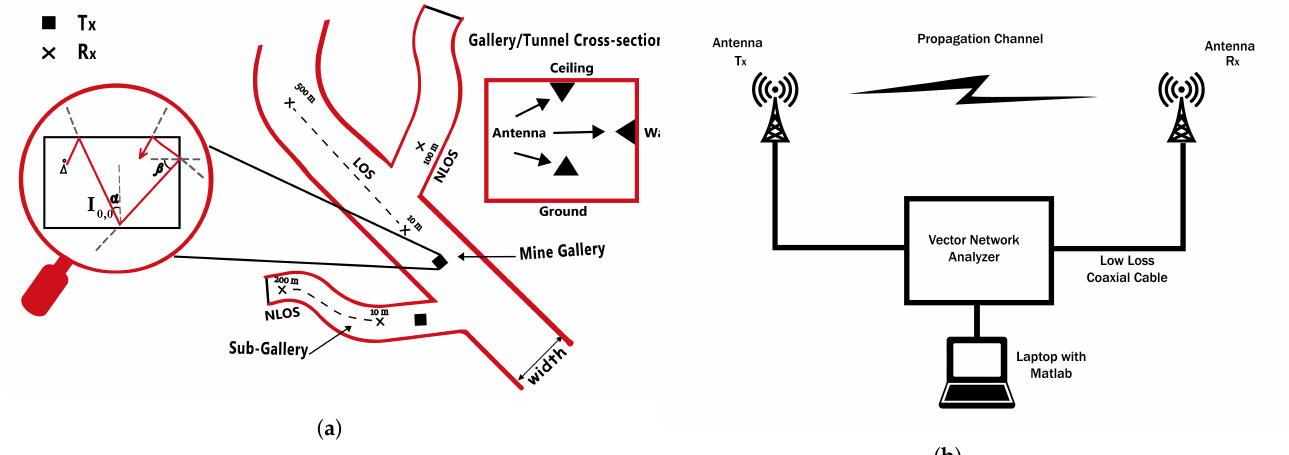
Figure 4. Layout of an underground coal mine, ( a ) Underground mine galleries, ( b ) Channel measurement